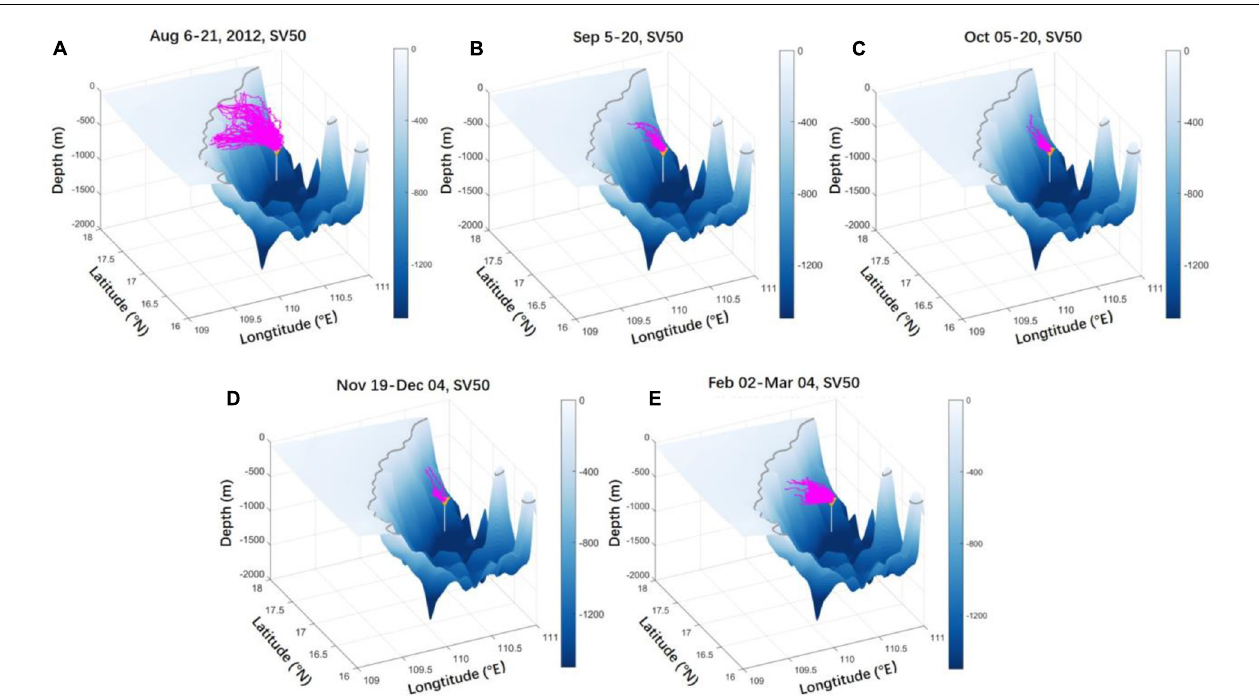
FIGURE 7 | Backtracking of particles released at a water depth of 1,000 m with sv = 50 m · day − 1 and reaching the continental slope (A) from August 6 to 21, (B) from September 5 to 20, (C) from October 5 to 20, and (D) from November 19 to December 4 of 2012, and (E) from February 2 to March 4 of